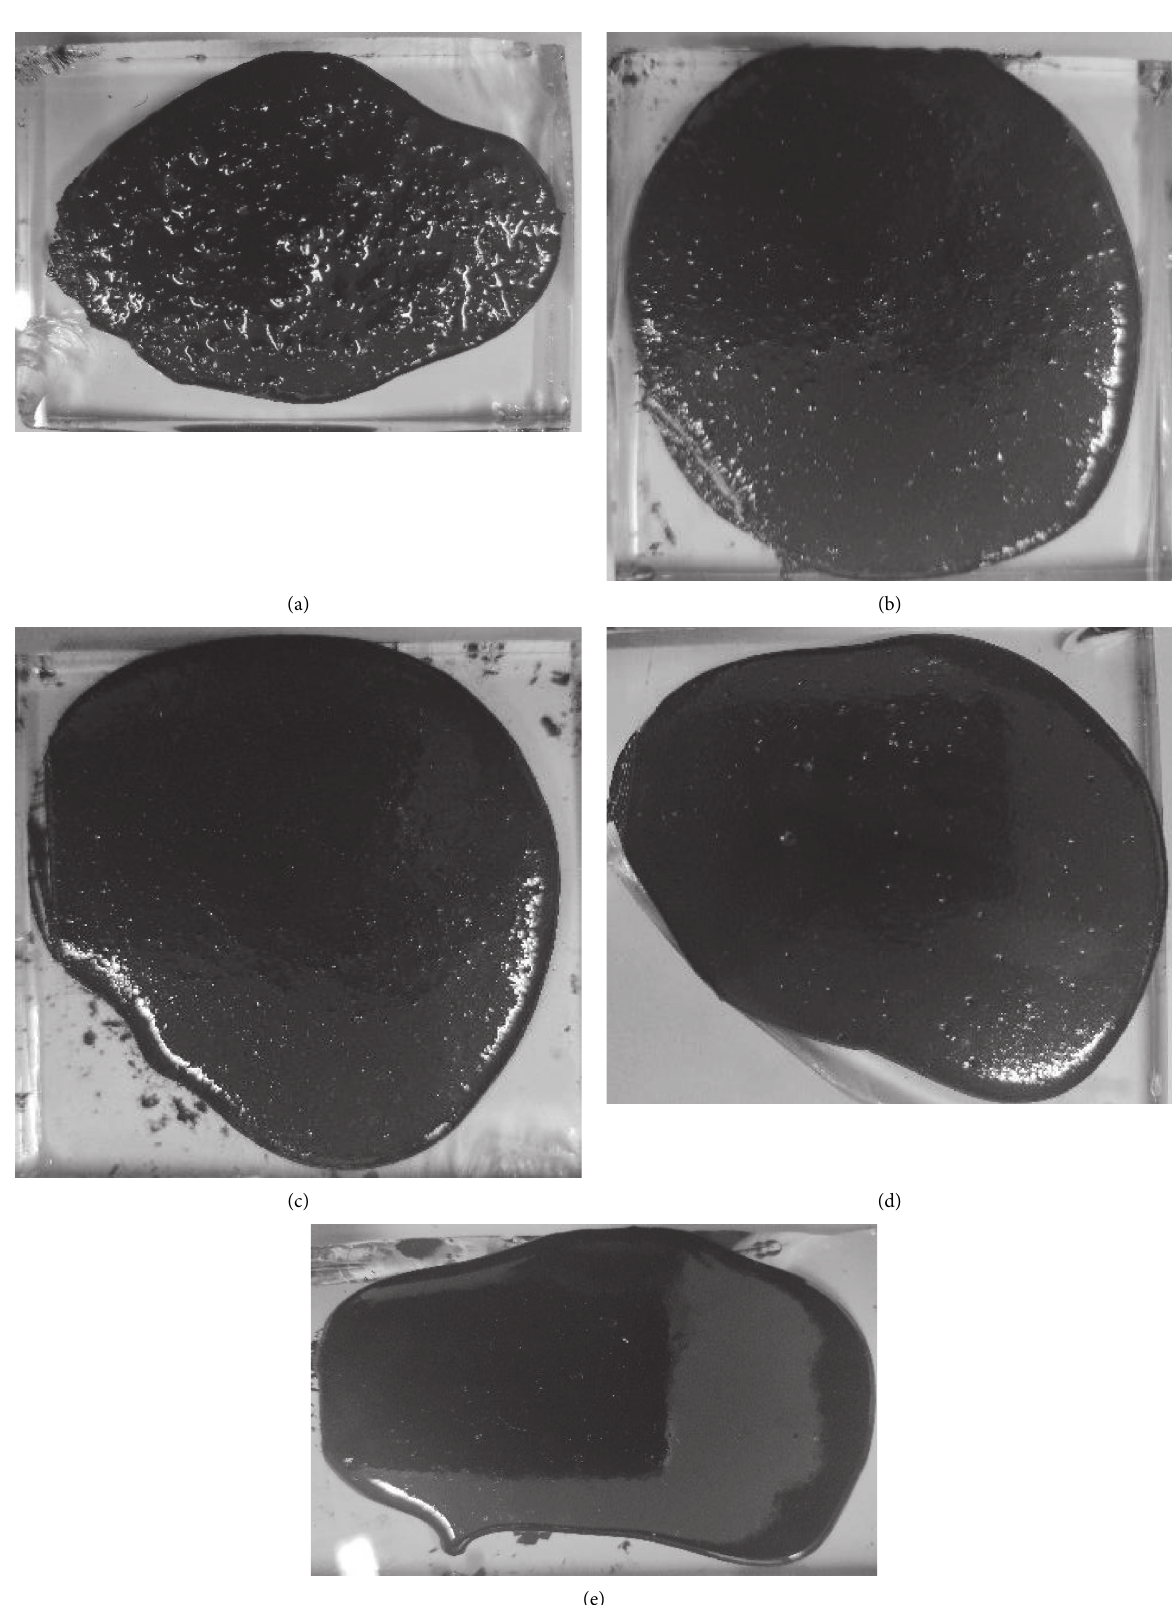
Figure 1: AR binders with different CR particle sizes. (a) AR with #20 CR, (b) AR with #30 CR, (c) AR with #40 CR, (d) AR with #60 CR, and (e) AR with #80